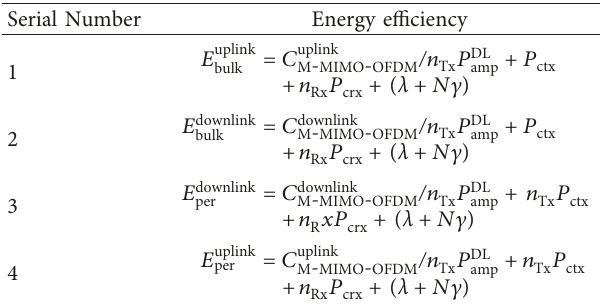
Table 2: Proposed EE expression of the M-MIMO-OFDM system with per-subcarrier and bulk antenna selection